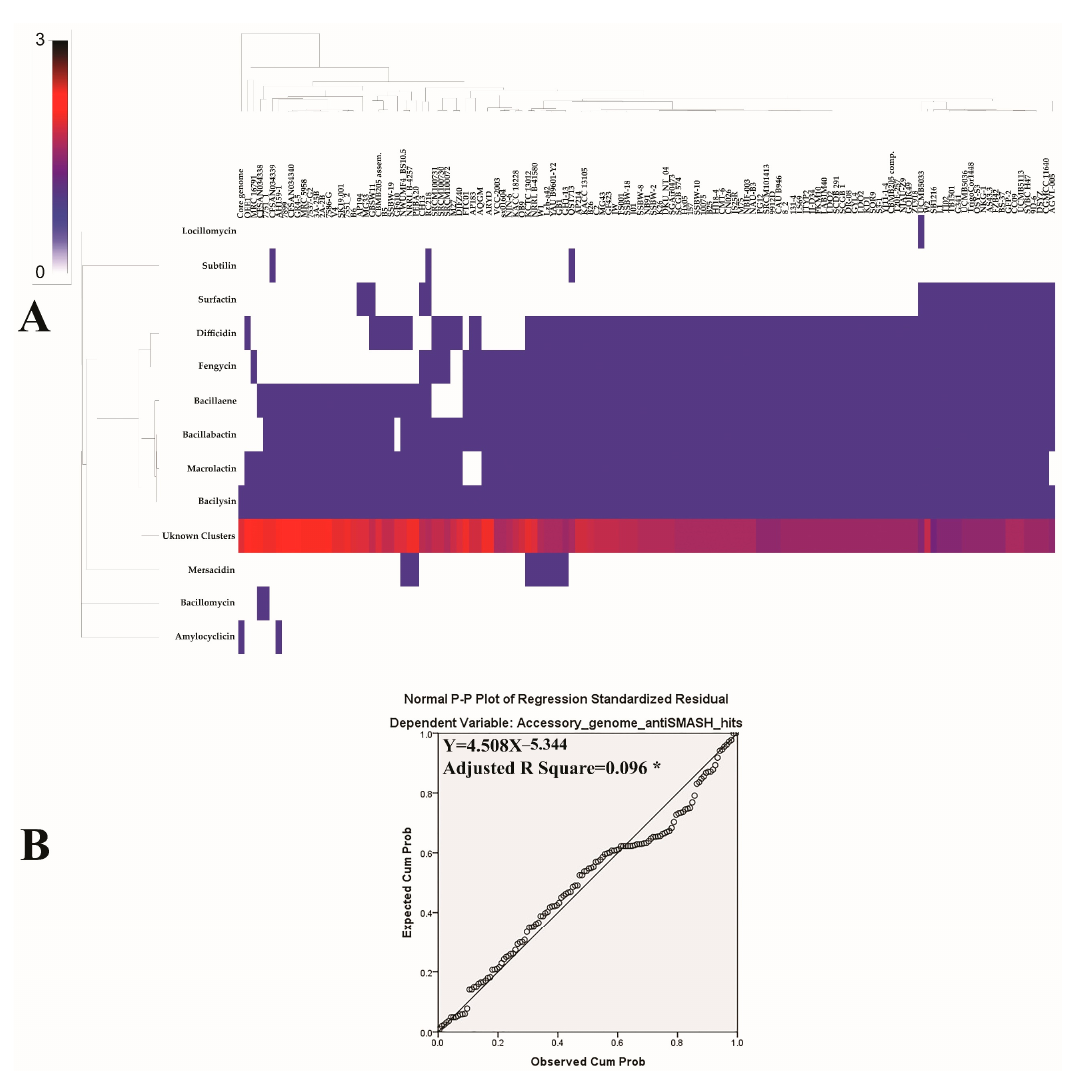
Figure 5. ( A ) Heat map of Bacillus velezensis core and accessory genome secondary metabolites. ( B ) Statistically significant linear relationship between genome sizes and accessory genome antiSMASH total hits ( p < 0.05).